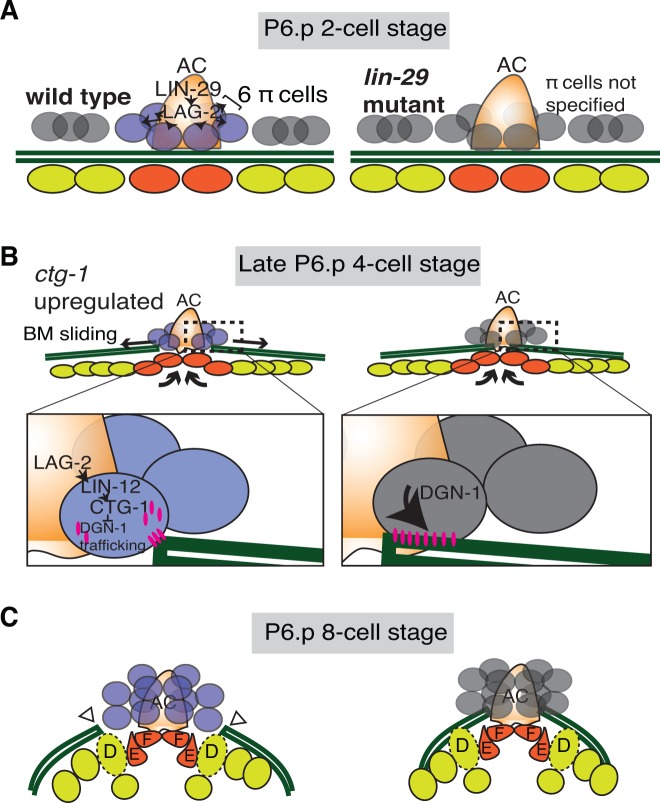
Summary of uterine boundary cell regulation of BM sliding.(A) A schematic diagram of the mid L3 stage in wild type (left). The Kruppel-family EGR protein LIN-29 acts in the AC to maintain LAG-2 (Notch ligand) expression, which induces the π cell fate in the six VU cells that contact the AC. This specification event fails to occur in lin-29 mutants (right). (B) During the late L3 stage after AC invasion, invagination, growth, and division of the vulval cells generates forces that promote BM sliding in wild type animals (left). Within the π cells (inset), LAG-2 binding of LIN-12(Notch) activates transcriptional upregulation of ctg-1, which encodes a Sec14-GOLD phospholipid transfer protein. CTG-1 restricts BM receptor DGN-1 (dystroglycan) trafficking to the cell-BM interface of the π cells, thus decreasing their adhesion to the BM and allowing BM sliding. In lin-29 mutants (right) ctg-1 expression is not upregulated in the unspecified ventral uterine descendant cells, and more DGN-1 is trafficked to the cell-BM interface, maintaining cell adhesion to the BM and preventing sliding. (C) At the early-to-mid L4, the BM gap edges have slid (arrowheads) and stabilize over the vulval D cells and at the edges of uterine π cells in wild type animals (left). In contrast, the BM does not slide in lin-29 mutants and maintains its position adjacent to the AC (right).